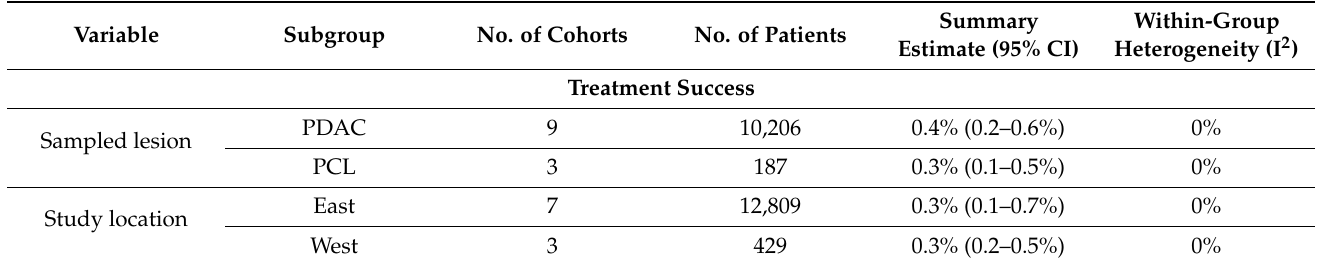
Figure 2. Pooled analysis of needle tract seeding rate in patients who underwent EUS-guided tissue acquisition. Pooled rate of needle tract seeding was 0.3% (95% CI 0.2–0.4%), with no evidence of heterogeneity (I 2 = 0%). Table 2. Sensitivity analysis of needle tract seeding. Sensitivity analysis was performed based on (a) sampled lesion (adenocarcinoma vs. pancreatic cysts), and (b) study location (East vs. West).